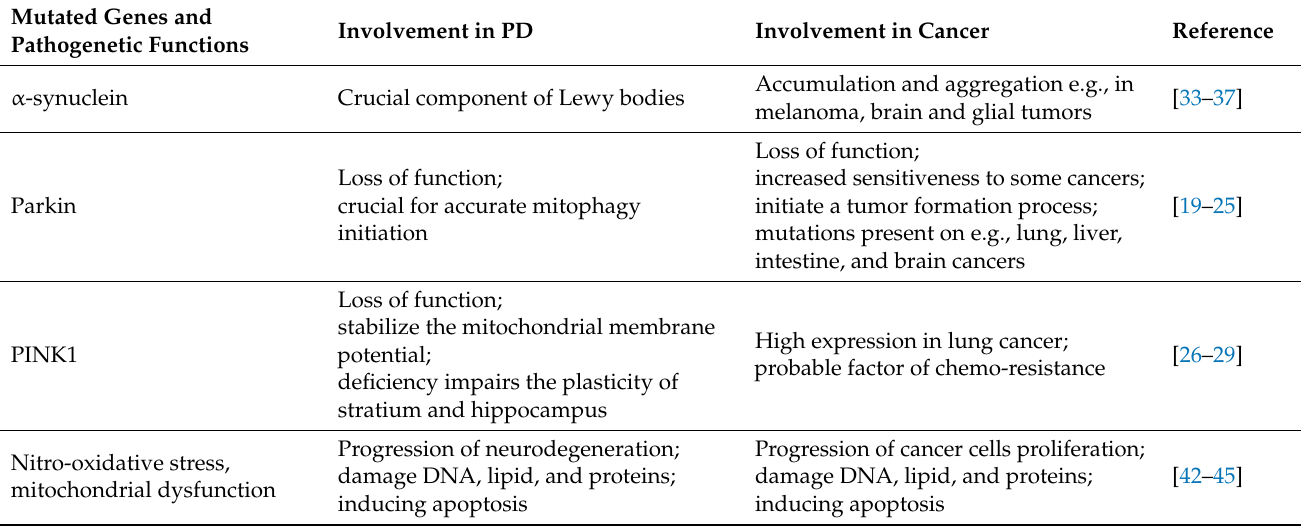
Table 1. Shared pathogenetic factors for cancers and